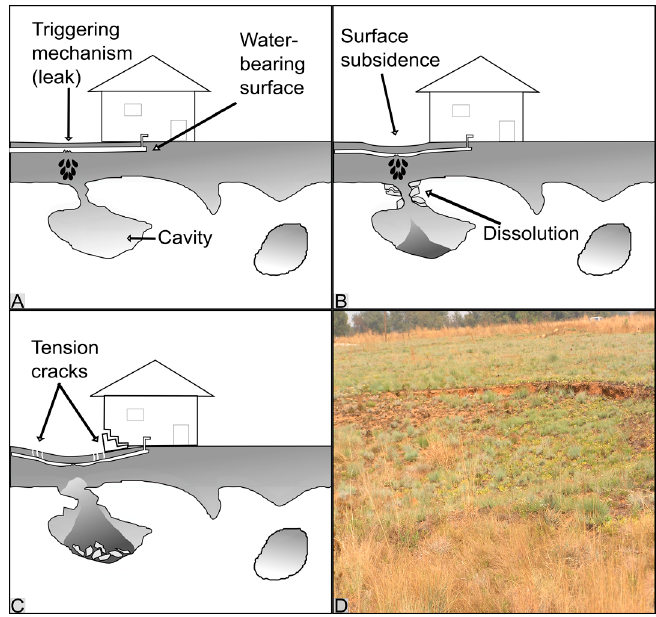
Figure 1. A graphic representation of subsidence basin formation. ( A ) The presence of a cavity